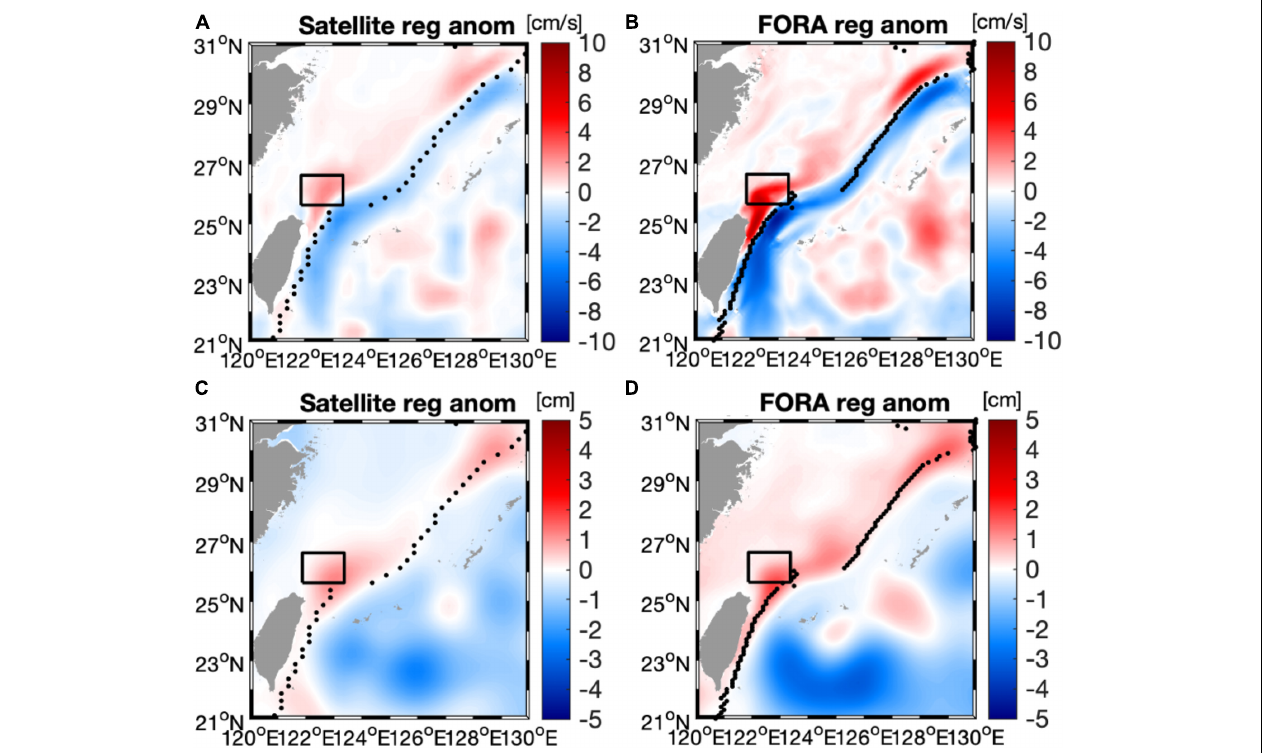
FIGURE 4 | Regressed anomalies of (A,B) surface current speed and (C,D) sea surface height targeting the KSI strength modes. Regression analysis was based on satellite altimetry for 1993–2018 ( left ) and FORA for 1993–2014 ( right ). The mean path of the Kuroshio is displayed as black dots. Black squares denote the KSI